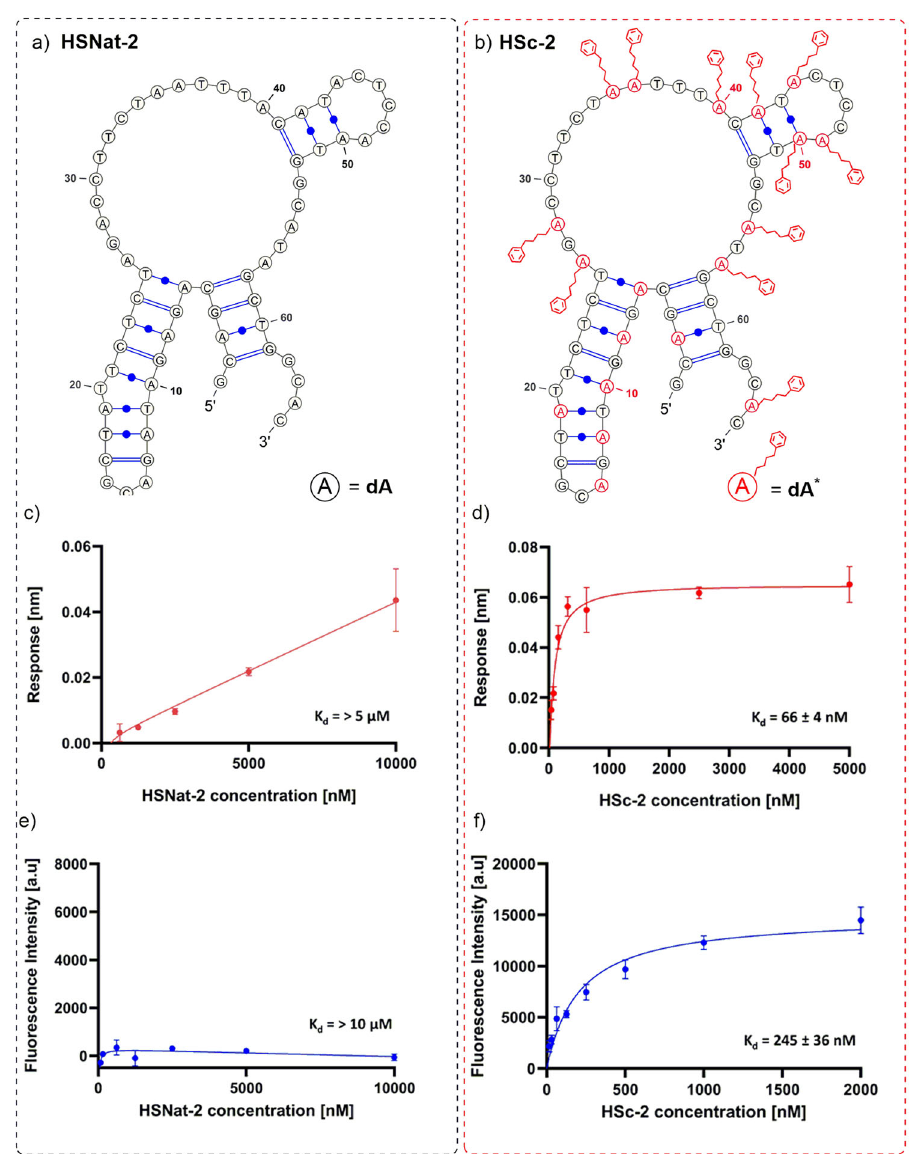
Fig. 4 Binding af fi nity results of the natural HSNat-2 sequence and modi fi ed HSc-2 aptamer. a , b the potential predicted secondary structure for the HS- 2 aptamers as determined by MFold. BuPh-modifed dA* side chains are highlighted in red for visualisation. c , d The corresponding binding curves for HS-2 aptamers as determined by BLI, different aptamer concentrations were used as analyte and the steady state binding af fi nity [K d ] was calculated. e , f The corresponding binding curves for HS-2 aptamers as determined by the fl uorescent-plate-based binding assay. The raw fl uorescent data were exported into Graph Prism and the binding af fi nity [K d ] of each aptamer calculated. Error bars represent the average values of 2 independent Fig. 5i. The plate-based binding assay determined the K d to be even lower at 14.8 ± 0.3 nM. These results con fi rm that the truncated aptamer is not dependent on the 5 ′ fi xed sequence, suggesting that this region does not have an important role in target binding. This agrees with other truncation studies 45,46 that have concluded fi xed primer sequence regions are less important Fig. S17. The response data was exported and further analysed by for aptamer function and may be eliminated. Graph Prism which is displayed in Fig. 5f. The K d values of HSc- 9.1, as obtained by the BLI showed further enhancement of the binding af fi nity towards Hsp70 as a result of truncation with a steady state af fi nity reported of 29.1 ± 2 nM. This binding af fi nity result was again cross-checked with the plate-based binding assay binding af fi nity was evaluated using BLI upon incubation with using synthesised HSc-9.1 that was labelled with 6-FAM fl uor- three alternative His-tagged proteins readily available in our ophore at the 5 ′ end. The fl uorescence data was exported to laboratory, namely His-SUMO, the protein acidic C-terminus Graph Prism and the resulting binding curves are displayed in (His-CPA) and N-terminus (His-NPA) of RNA-dependent RNA